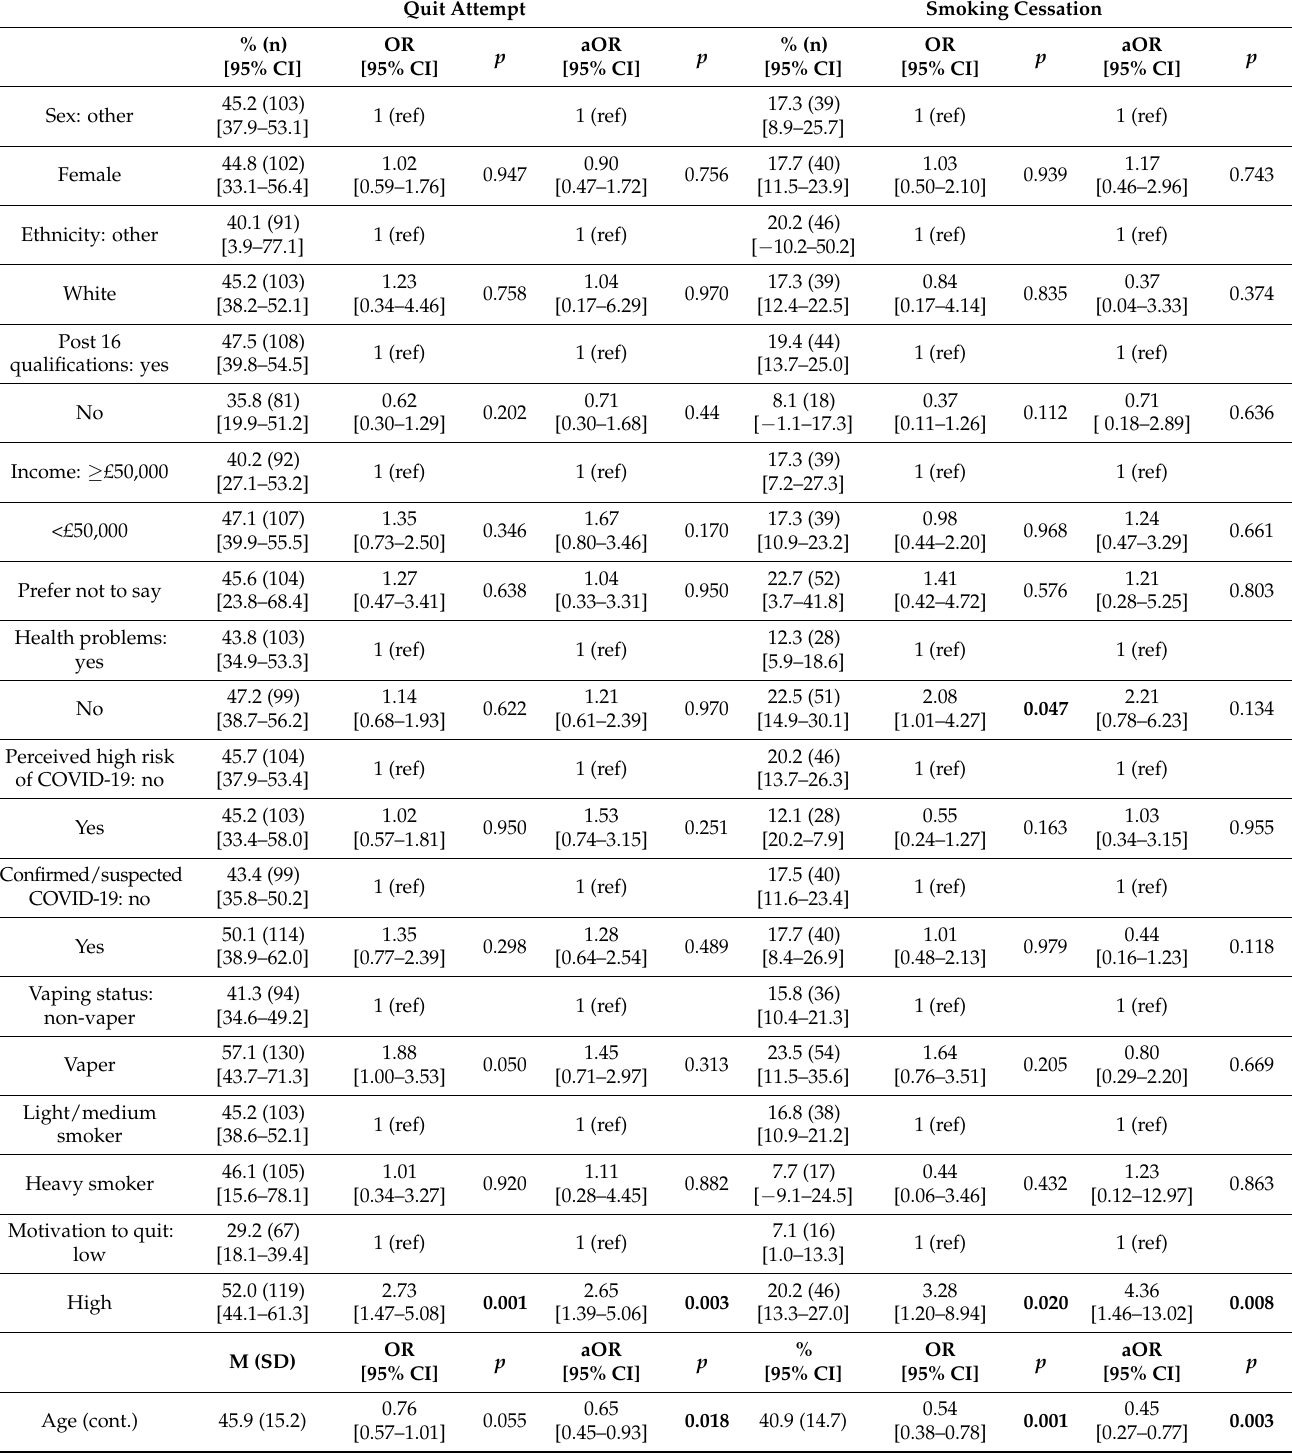
Table 2. Predictors of making a quit attempt and smoking cessation at 12-month follow up among smokers at baseline (N =